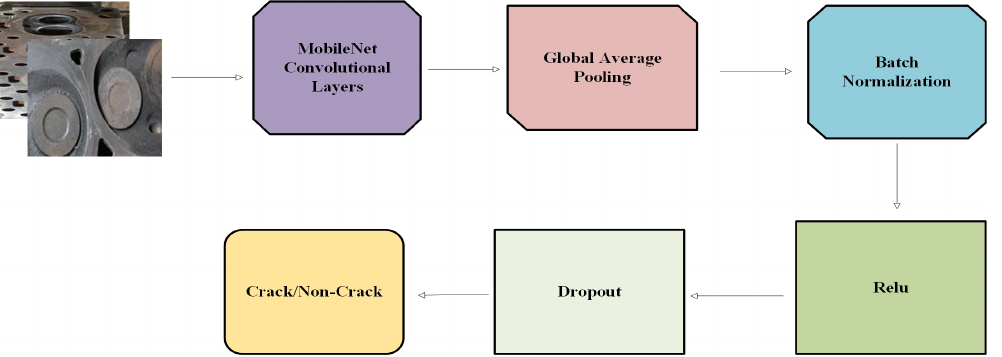
Figure 5. Framework of the MobileNet